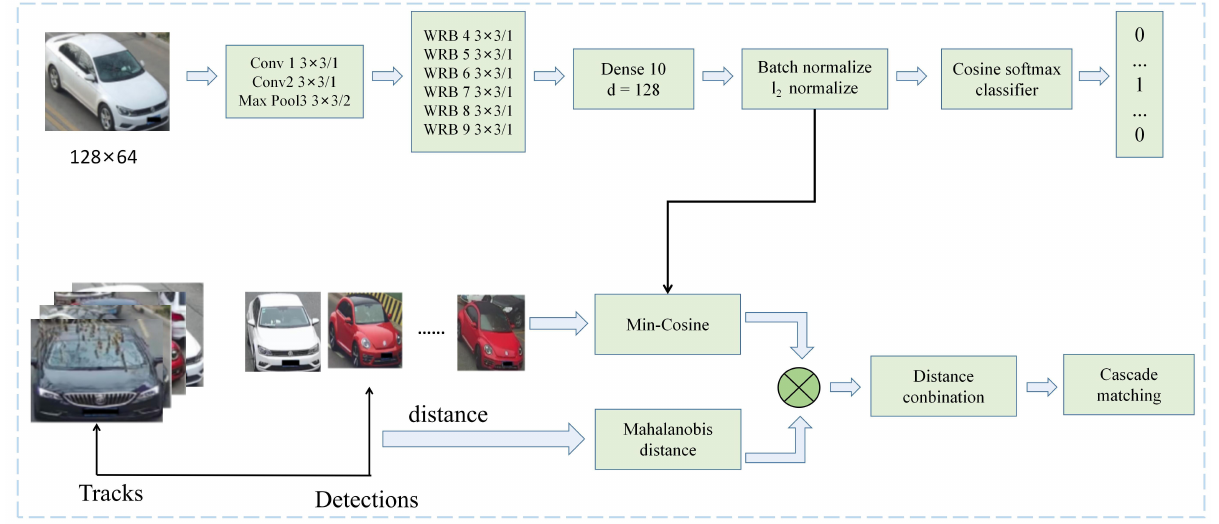
Figure 5. The framework of depth SORT